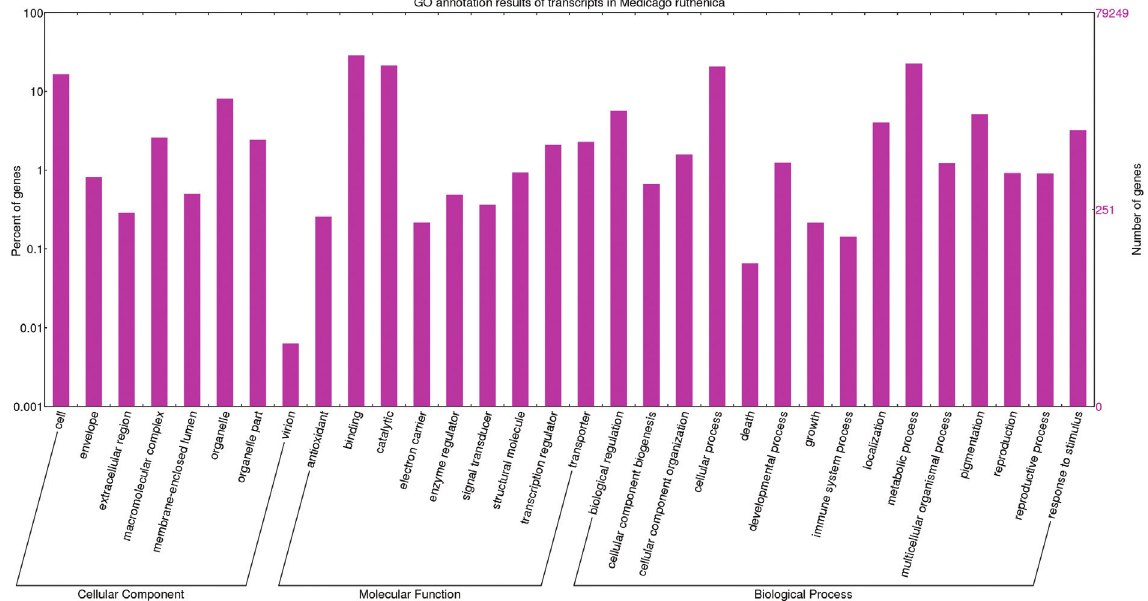
Figure 3 - GO classification results for annotated unique transcripts in Medicago ruthenica . The Medicago ruthenica transcripts were annotated using BLASTP searches against transcriptome databases for M. truncatula , soybean, and Arabidopsis, and the results were categorized and viewed using